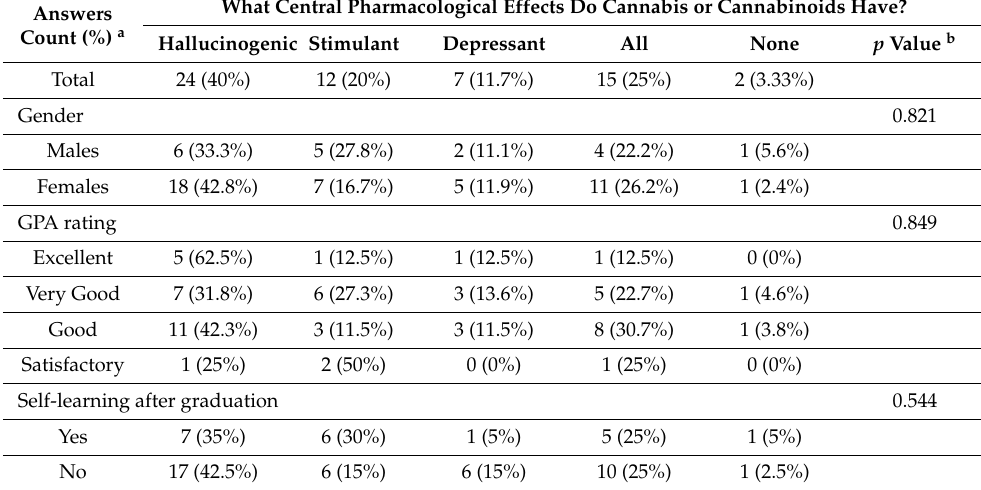
Table 4. Impact of demographics on participant perceptions of central cannabinoid